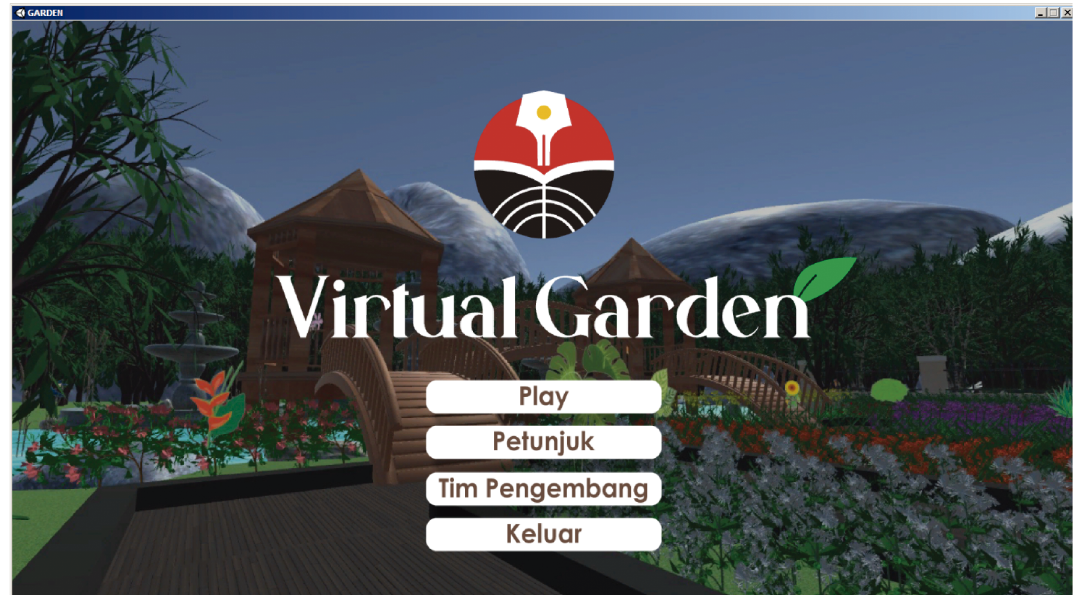
Figure 3. Initial View of Virtual Garden